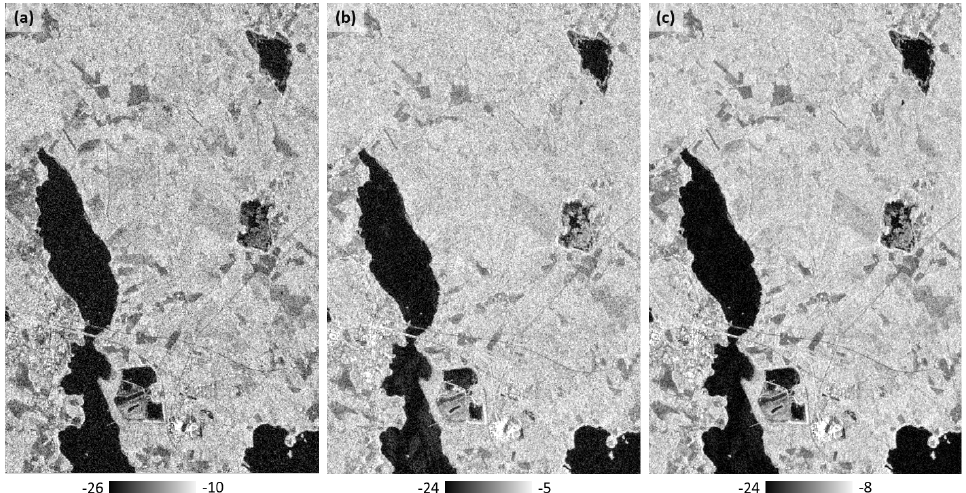
Figure 4. Sentinel-1 backscattering coefficients of study area without speckle-filtering, 12 May 2021, path 153: ( a ) σ 0 ; ( b ) σ 0 ; and ( c ) σ 0 VH VV VHVV